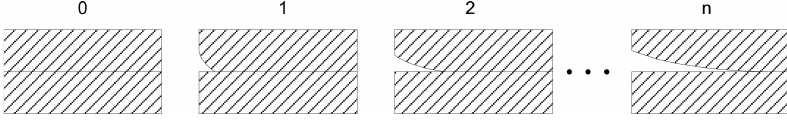
Figure 2. Fatigue crack